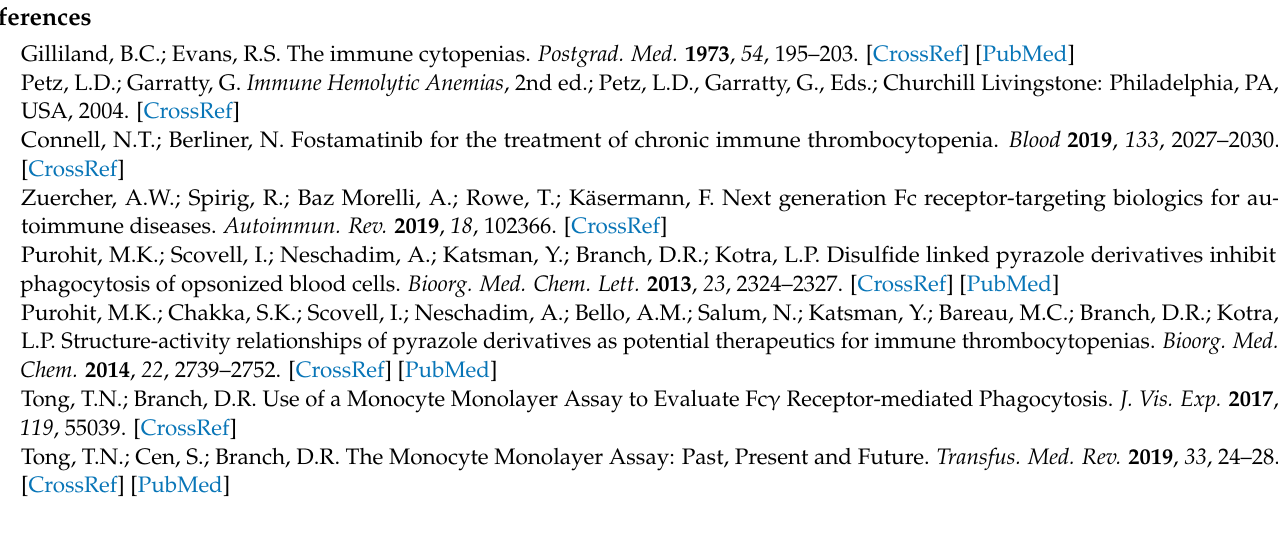
KB-208 ; Figure S9: UHPLC-HRMS/MS data of KB-210 ; Figure S10: HPLC-PDA chromatogram of KB-151 ; Figure S11: HPLC-PDA spectrum of KB-151 ; Figure S12: HPLC-PDA chromatogram of KB-198 ; Figure S13: HPLC-PDA spectrum of KB-198 ; Figure S14: HPLC-PDA chromatogram of KB-208 ; Figure S15: HPLC-PDA spectrum of KB-208 ; Figure S16: HPLC-PDA chromatogram of KB-210 ; Figure S17: HPLC-PDA spectrum of KB-210 ; Table S1: Purity results of hit